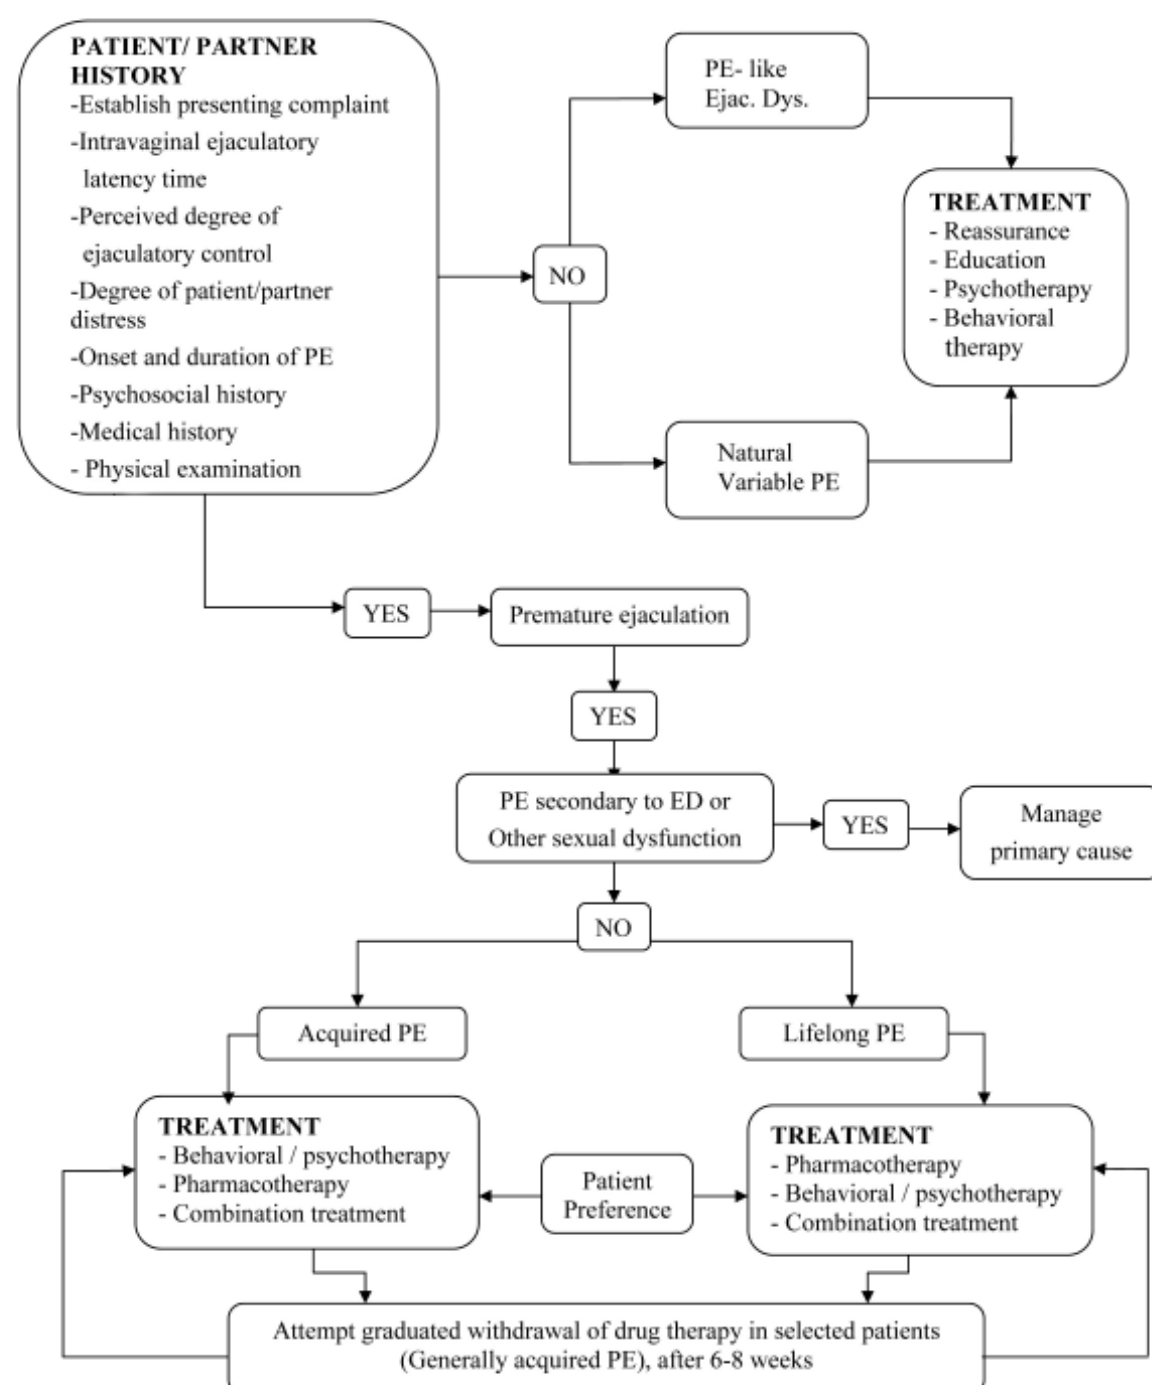
Figure 1. Premature ejaculation – ISSM management